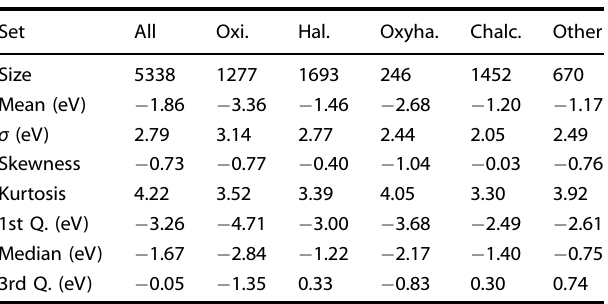
Fig. 2 Histogram of deformation potential estimator (cont.). Histograms of the estimators of the gap deformation potential ( e Ξ gap ) for different chemical systems (Oxides, Halides and Oxyhalides as de fi ned in the main text). The values are calculated within the PBE approximation. Table 1. Statistical analysis of distribution.